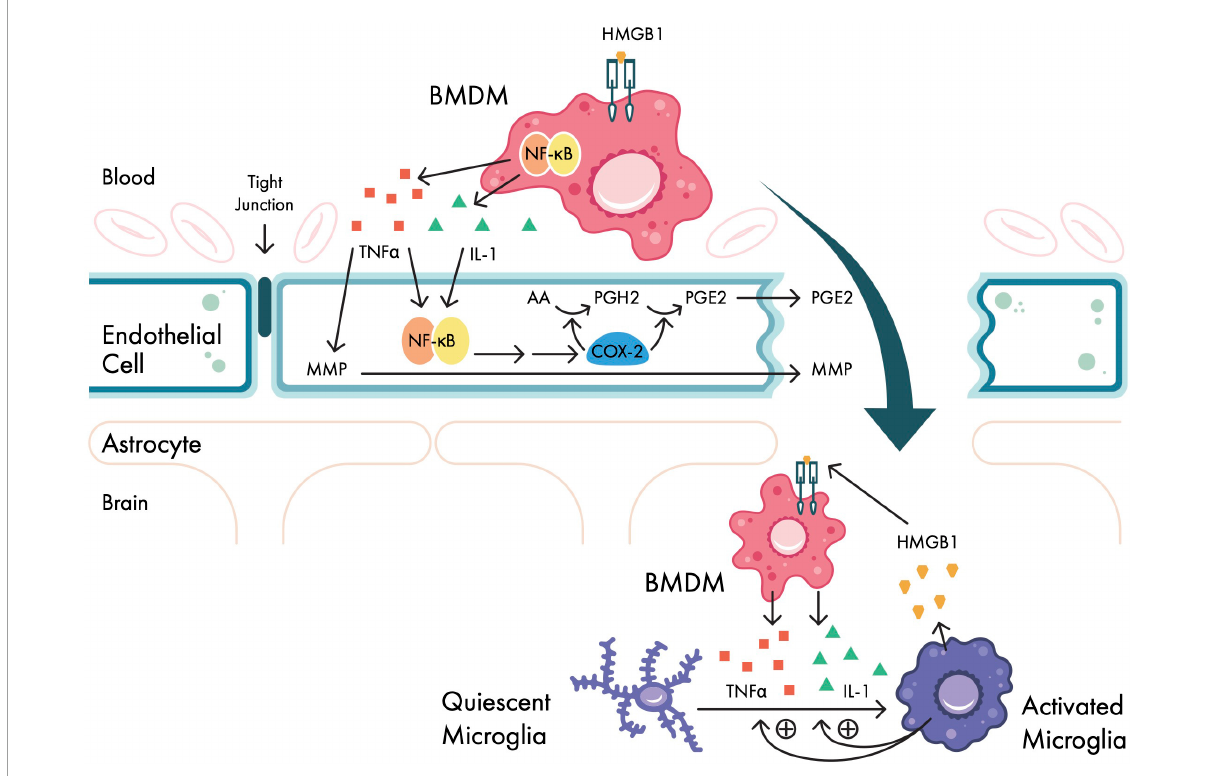
FIGURE2 Neuroinflammatory signaling pathways in response to surgical trauma. Bone-marrow derived monocytes (BMDMs) are activated in the periphery in response to surgical trauma via HMGB1. Activated BMDMs upregulate NF- κ B expression via second messenger systems, which in turn cause systemic release of pro-inflammatory cytokines IL-1, IL-6, and TNF α . At the blood–brain barrier (BBB), pro-inflammatory cytokines upregulate COX-2 (causing PGE2 production) and MMPs, disrupting BBB permeability. Activated BMDMs then migrate within the CNS, and further cytokine release activates microglia, which in turn activates BMDMs in a reciprocal manner. AA, arachidonic acid; BMDM, bone-marrow-derived monocyte; COX-2, cyclooxygenase 2 isozyme; HMGB1, high mobility group box-1 protein; IL-1, interleukin-1; IL-6, interleukin 6; MMP, matrix metalloproteinase; NF- κ B, nuclear factor-kappa B; PGE2, prostaglandin E2; PGH2, prostaglandin H2; TNF α , tumor necrosis factor alpha. Adapted from Safavynia and Goldstein